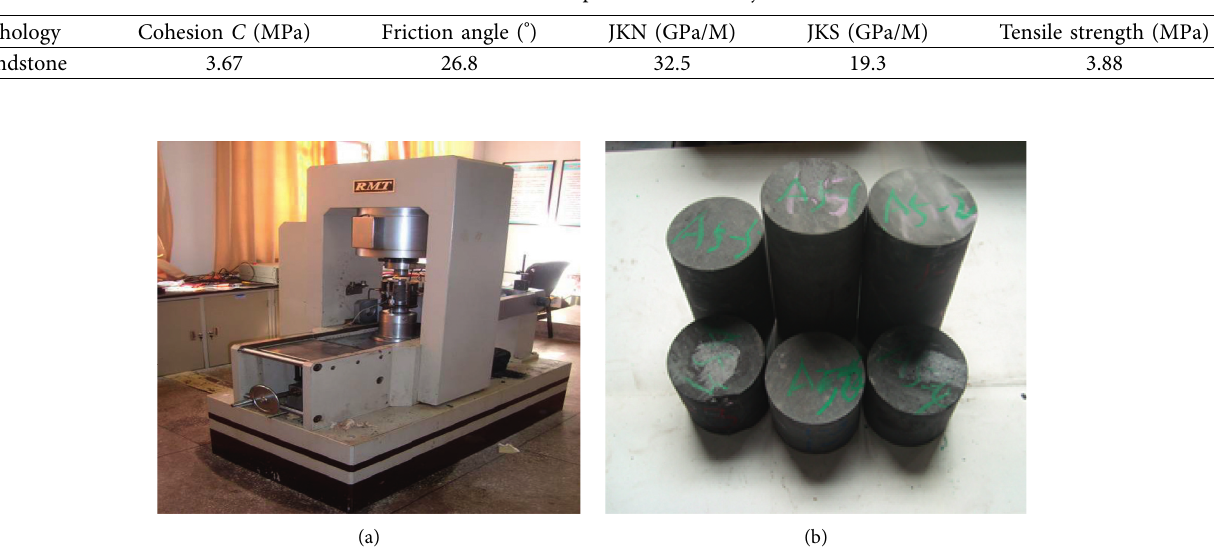
Table 2: Mechanical parameters of the joint.